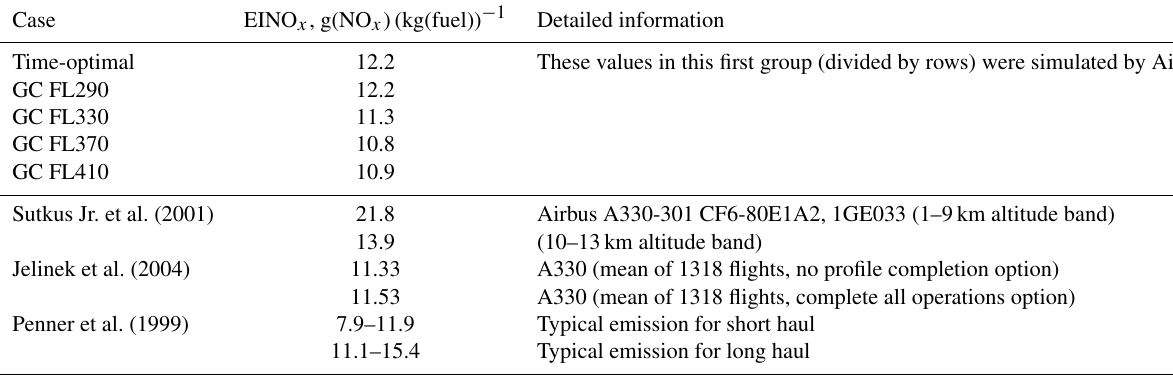
Table 13. The mean value of EINO x (in g(NO x )(kg(fuel)) − 1 ) for 103 flights. Some reference data of EINO x are provided by the literature in the table.